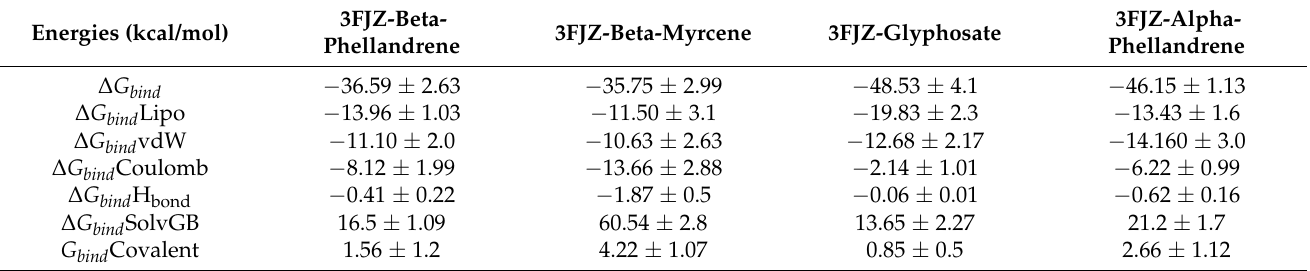
Table 5. Binding free energy components for the 3FJZ-glyphosate, 3FJZ- α -phellandrene, 3FJZ- β - phellandrene and 3FJZ- β -myrcene calculated by MM-GBSA. Energies (kcal/mol)